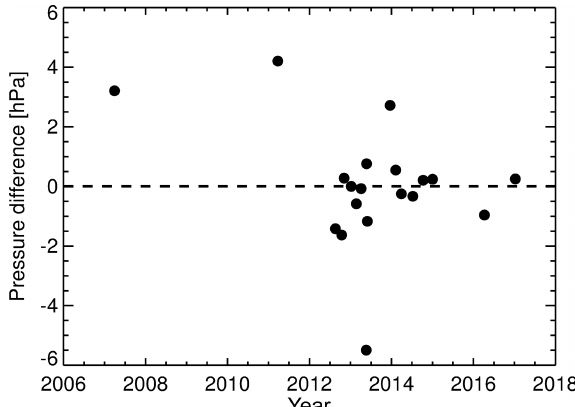
Figure E2. Difference between the FTIR MKS 902 cell pressure sensor and external PTB110 pressure sensor prior to any calibra- tion adjustments. Comparisons are conducted at a cell pressure of approx. 960hPa (atmospheric